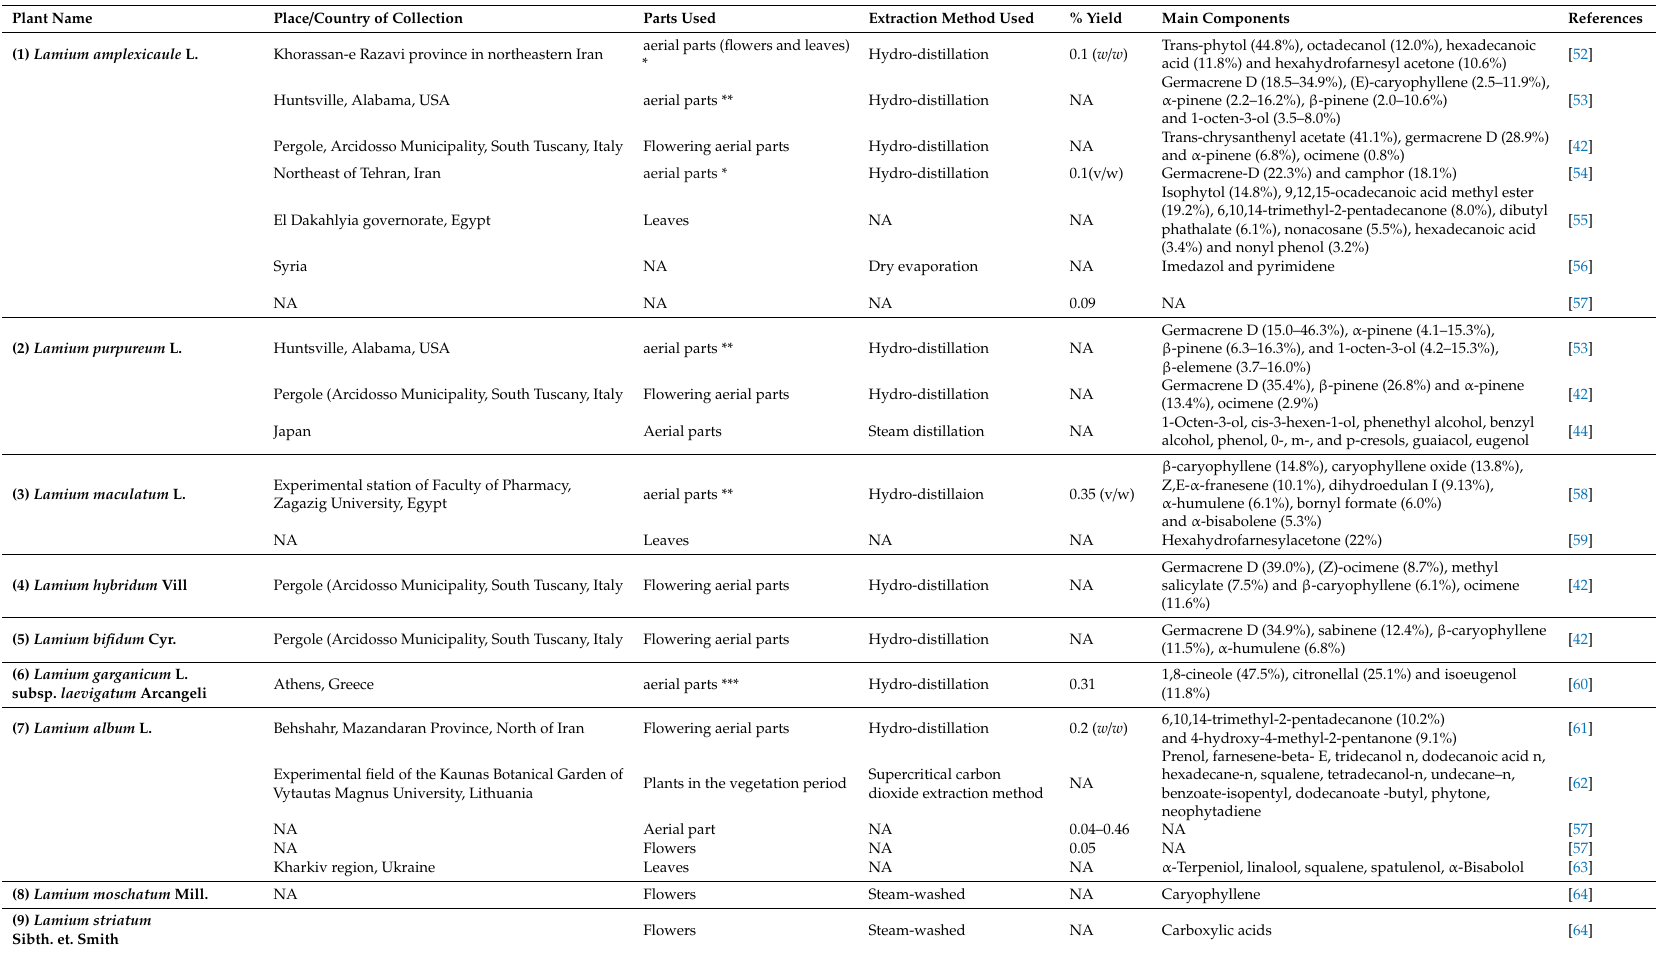
Table 1. Main components of essential oil from Lamium species studied from the year